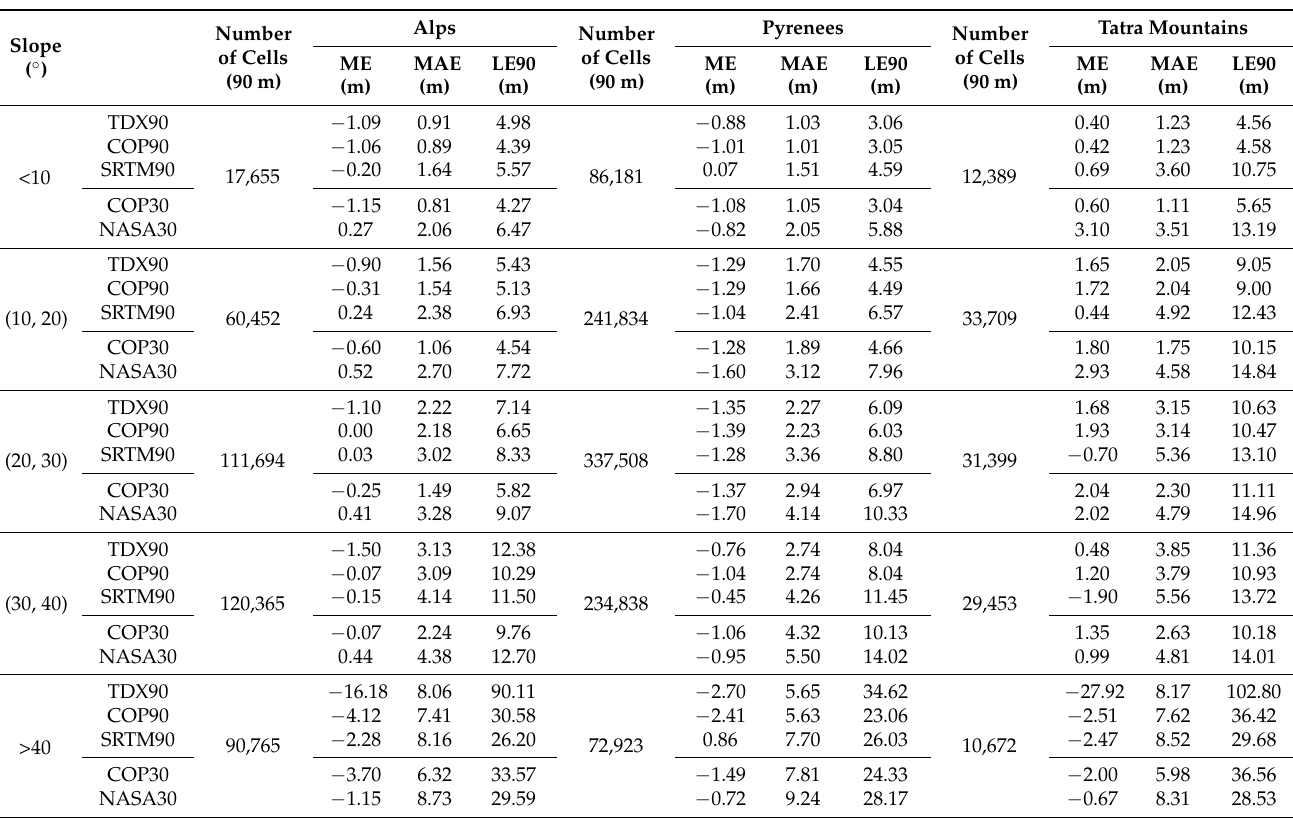
Table 2. Accuracy measures of the TDX90, COP90, SRTM90, COP30, and NASA30 error with respect Table 30. m resolution, the number of cells is approximately three times